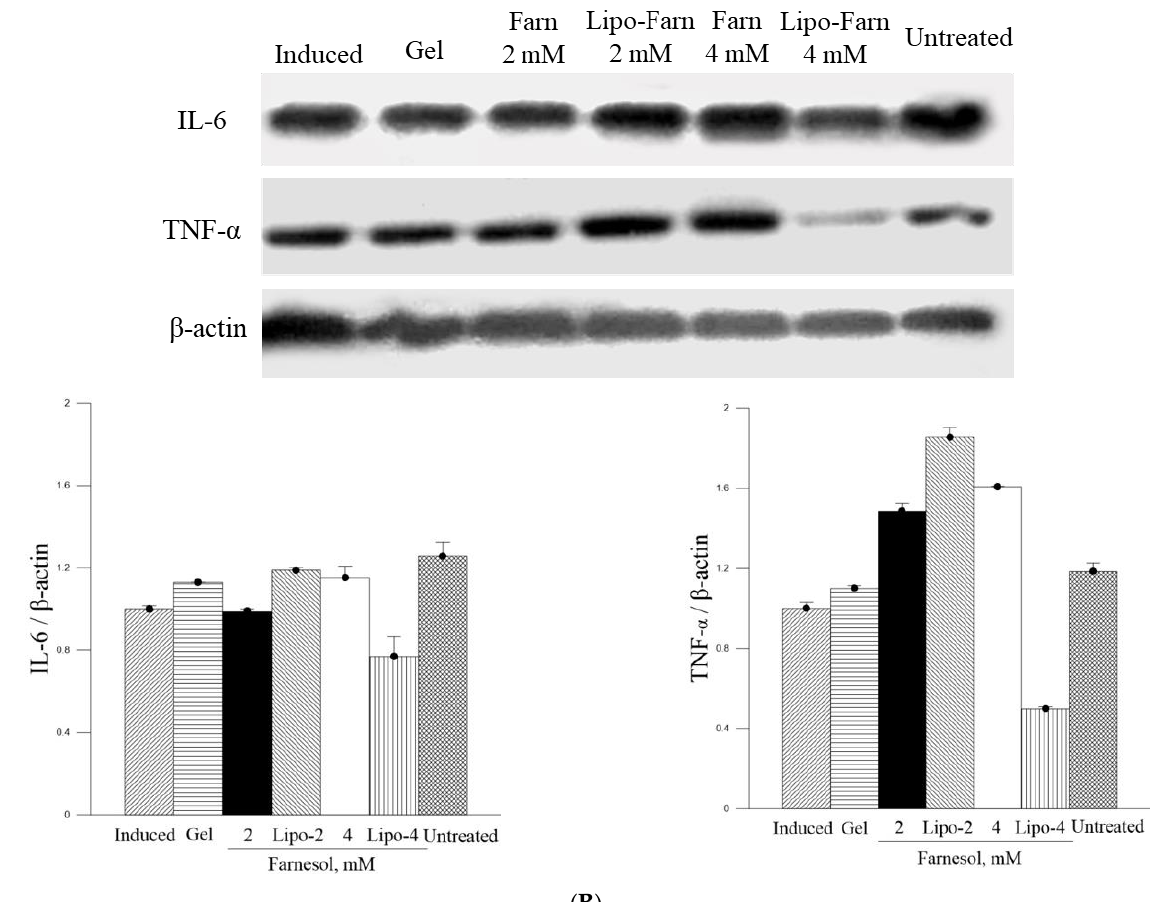
Figure 5. ( A ) Hematoxylin and eosin (H & E) staining and Masson’s trichrome staining for rat normal skin and the groups in post-PM 2.5 subcutaneous injective treatment category. In the histopathological analysis, different lesions caused by PM 2.5 were observed as follows. 1. Epidermal erosion, loss of keratin, parakeratosis coupled with hyperkeratosis. 2. Epithelial and follicle cysts arising from injured pilosebaceous units. 3. Rupture of the cyst lining, accumulation of exudates and keratin-like substance in the epidermis. 4. Inflammatory cell and fibroblast infiltration. 5. Fragmented, loose extracellular matrix and loss of extracellular collagen-like substance. Bar: 100 μ m. ( B ) Western blot analysis of IL-6 and TNF- α. The rat skin specimens were collected from the groups treated with or without gel, Farn, and Lipo-Farn after the subcutaneous injection of PM 2.5 (0.4 mL, 200 μg/mL).